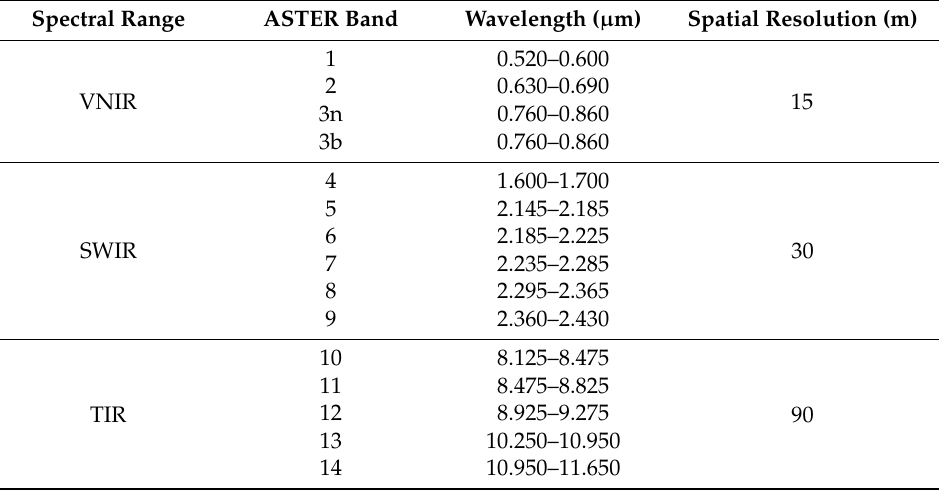
Table 1. Wavelength and spatial resolution of each ASTER